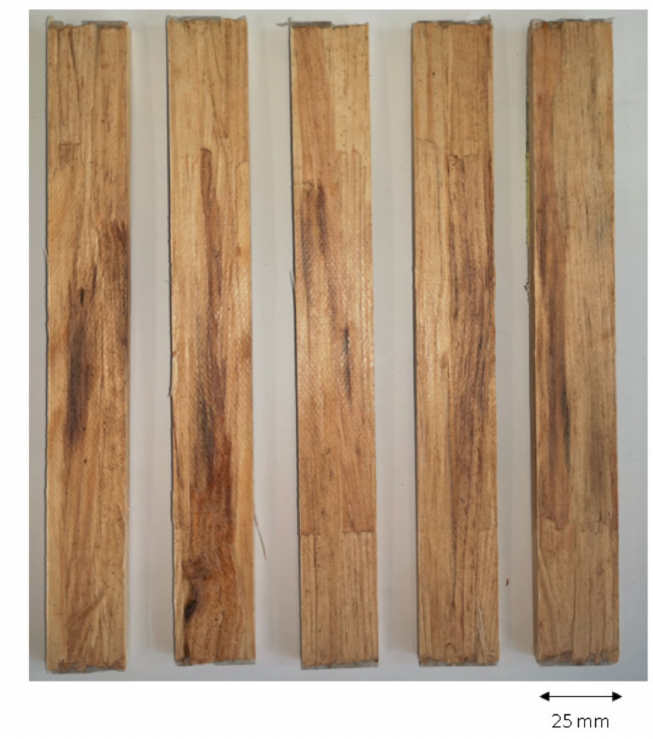
Figure 12. Manufactured WPC specimens for tensile testing.